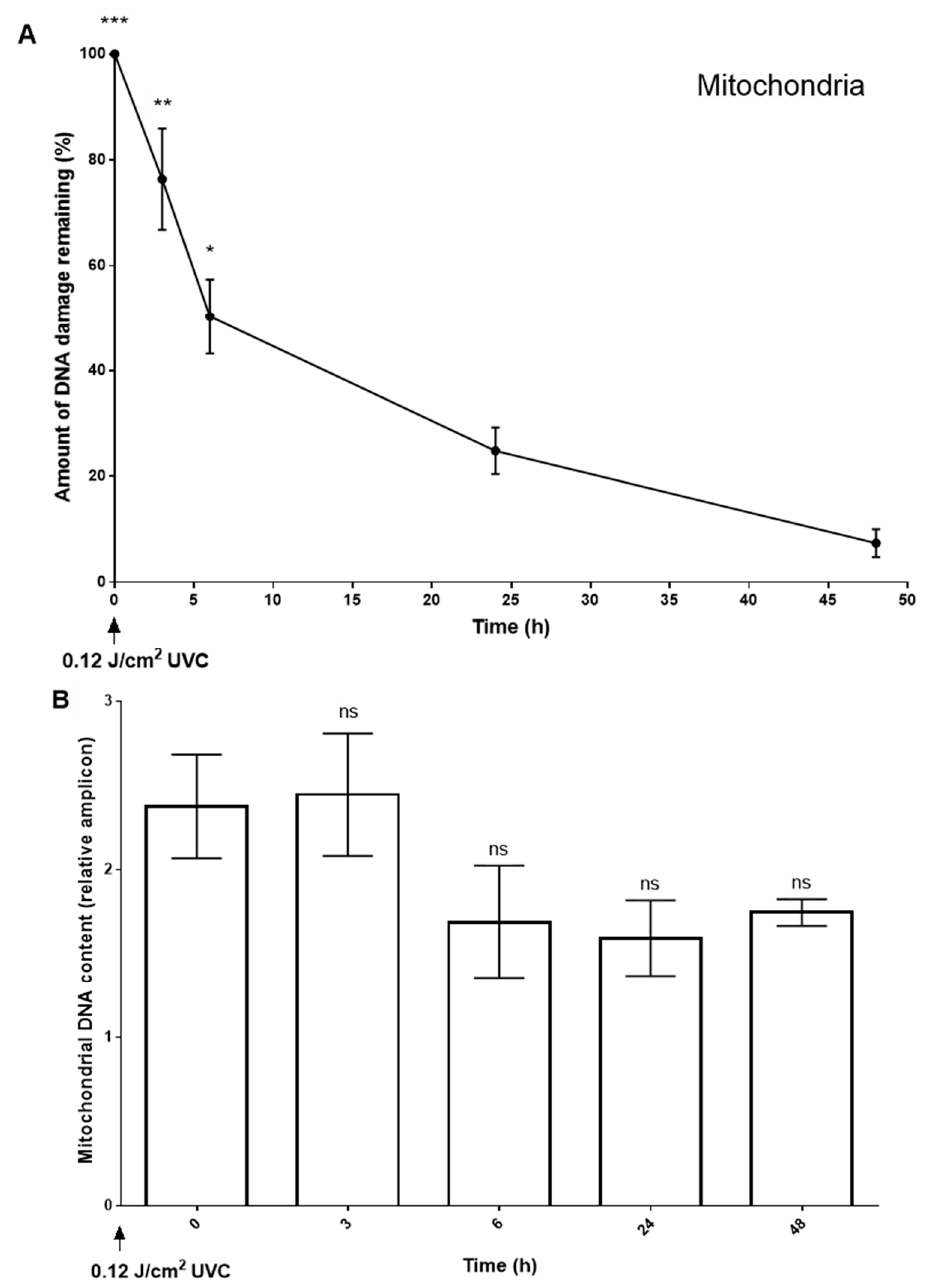
Figure 7. ( A ) The loss of solar simulated radiation induced-DNA damage (T <> T) from a representative region of the mitochondrial genome, determined by short-range qPCR. Points and bars represent the mean ± SEM of three independent experiments. *** p < 0.001, ** p < 0.01, and * p < 0.05, relative to an unirradiated sample. ( B ) Corresponding mitochondrial DNA content, from the experiment described in Figure 7A, determined by real-time qPCR. Bars represent the mean ± SEM of three independent experiments, ns = not significant, compared to the result for the zero h samples.